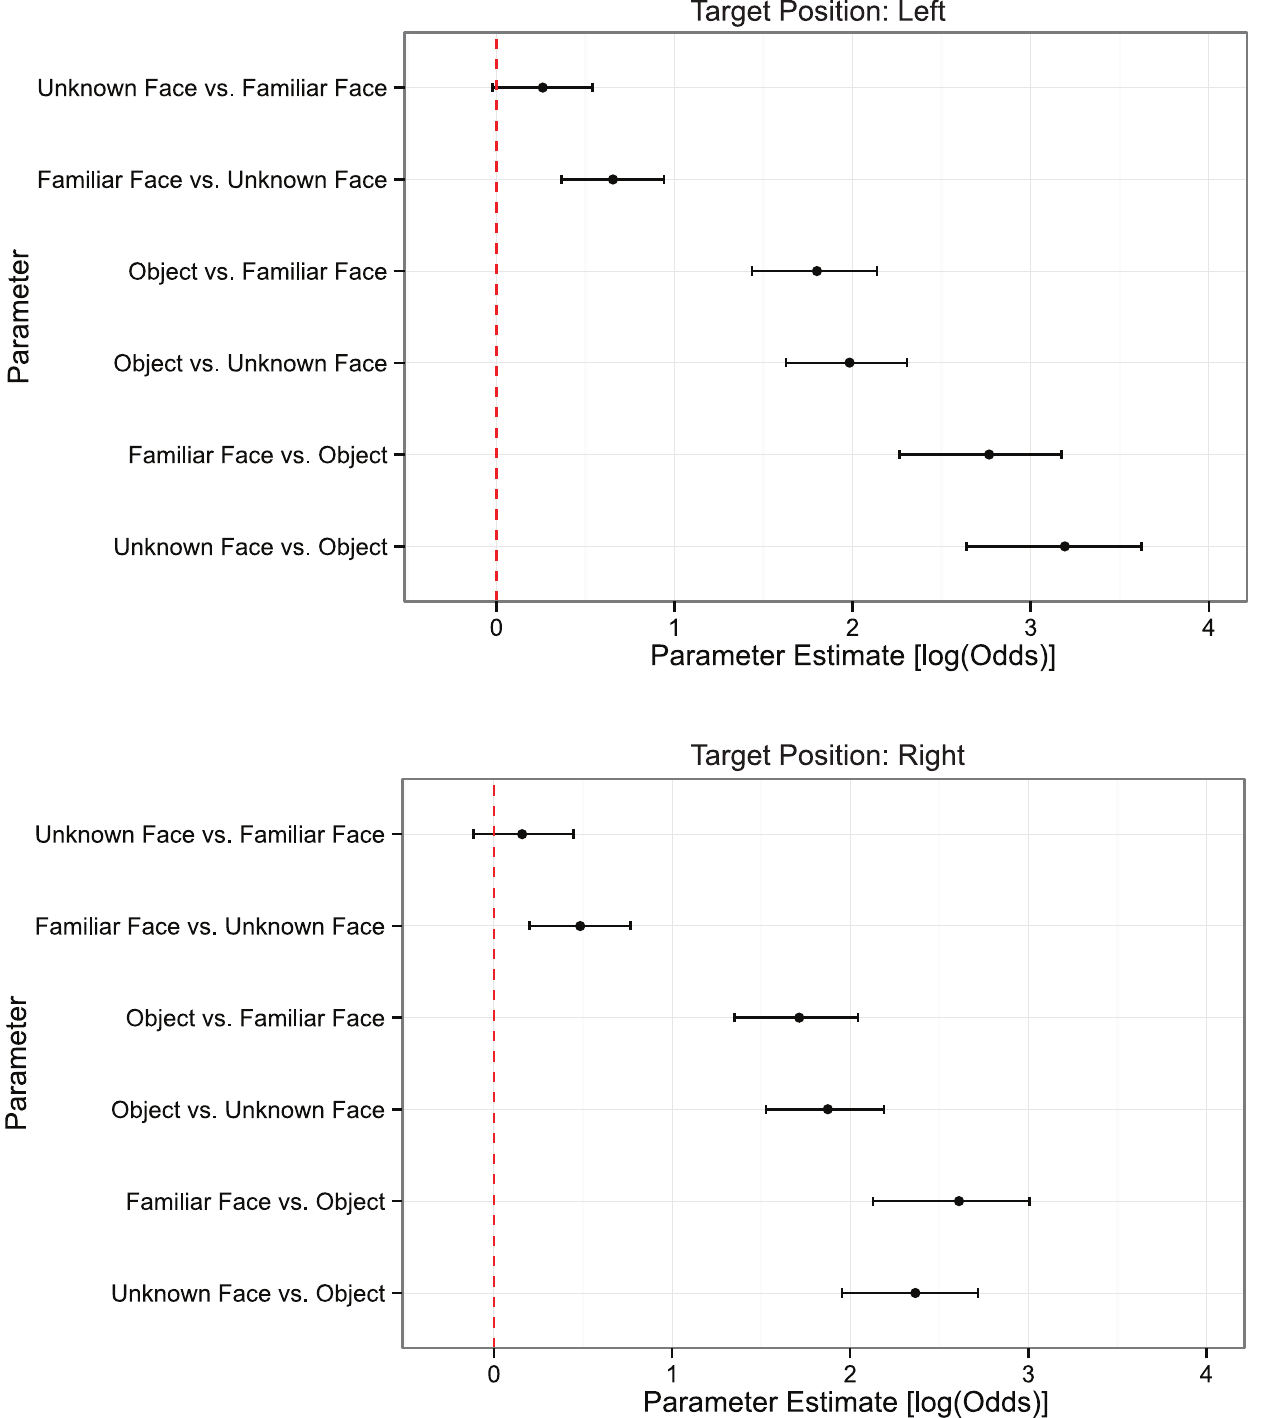
PLOS ONE | DOI:10.1371/journal.pone.0136548 August 25,